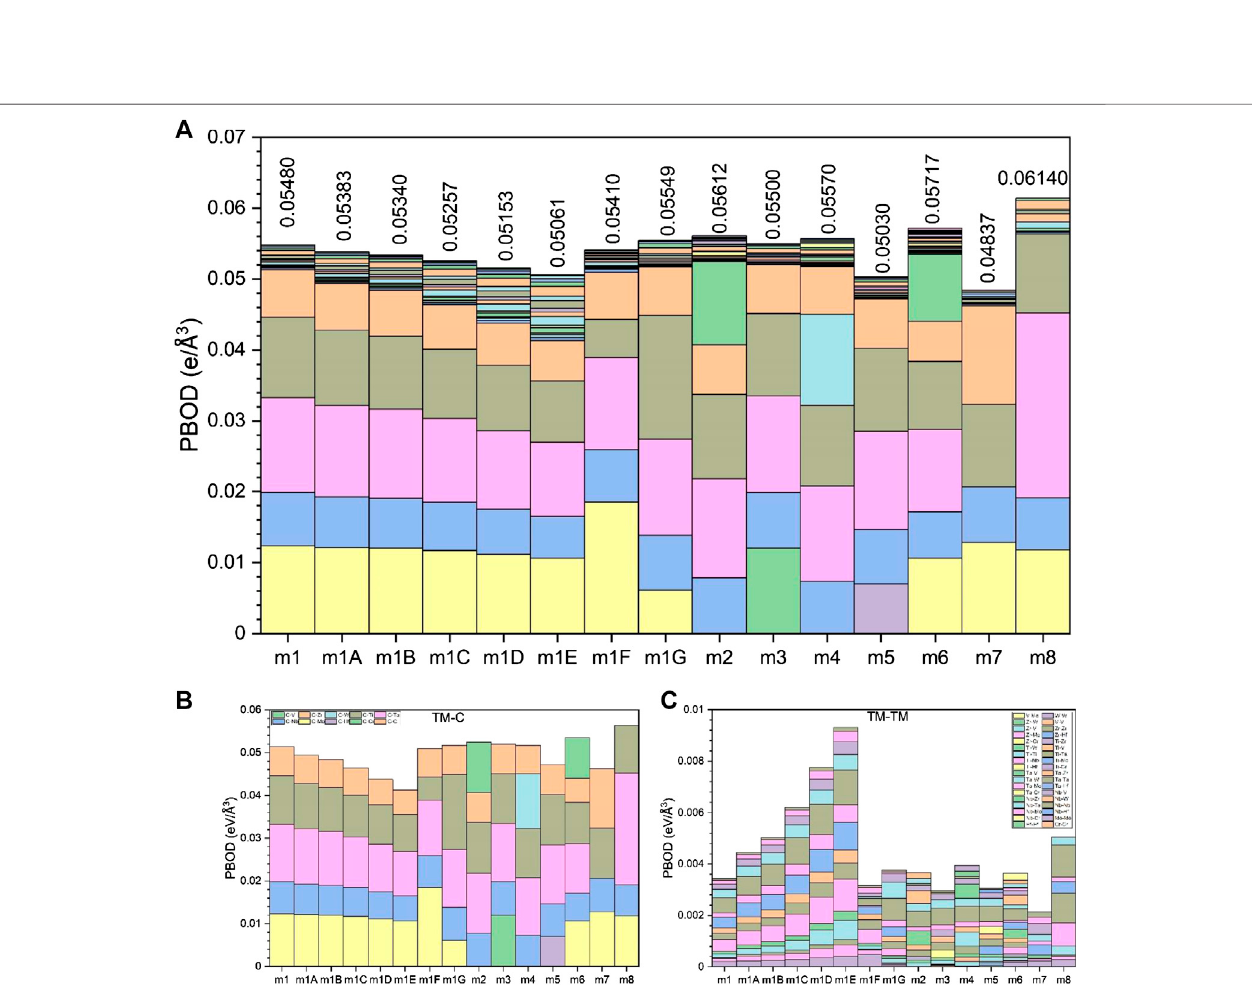
Frontiers in Materials |